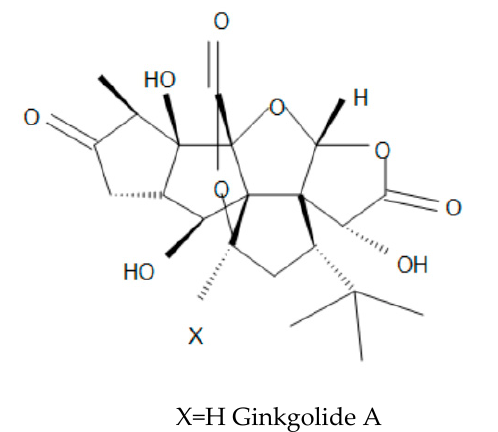
Figure 6. Chemical structure of Ginkgolide.